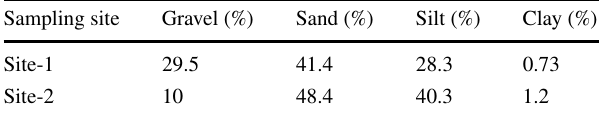
Table 2 Soil particle size distribution Sampling site